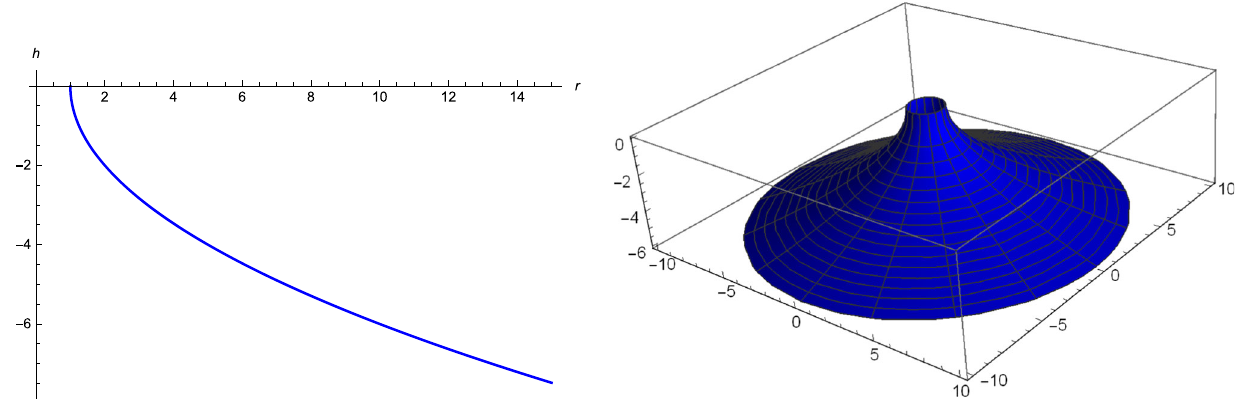
Fig. 4 Plot of embedding diagram for lower universe h ( r ) < 0 with respect to radial coordinate with slice t = const and θ = π/ 2. For a full visualization of the wormhole surface, took a 2 π rotation around the h